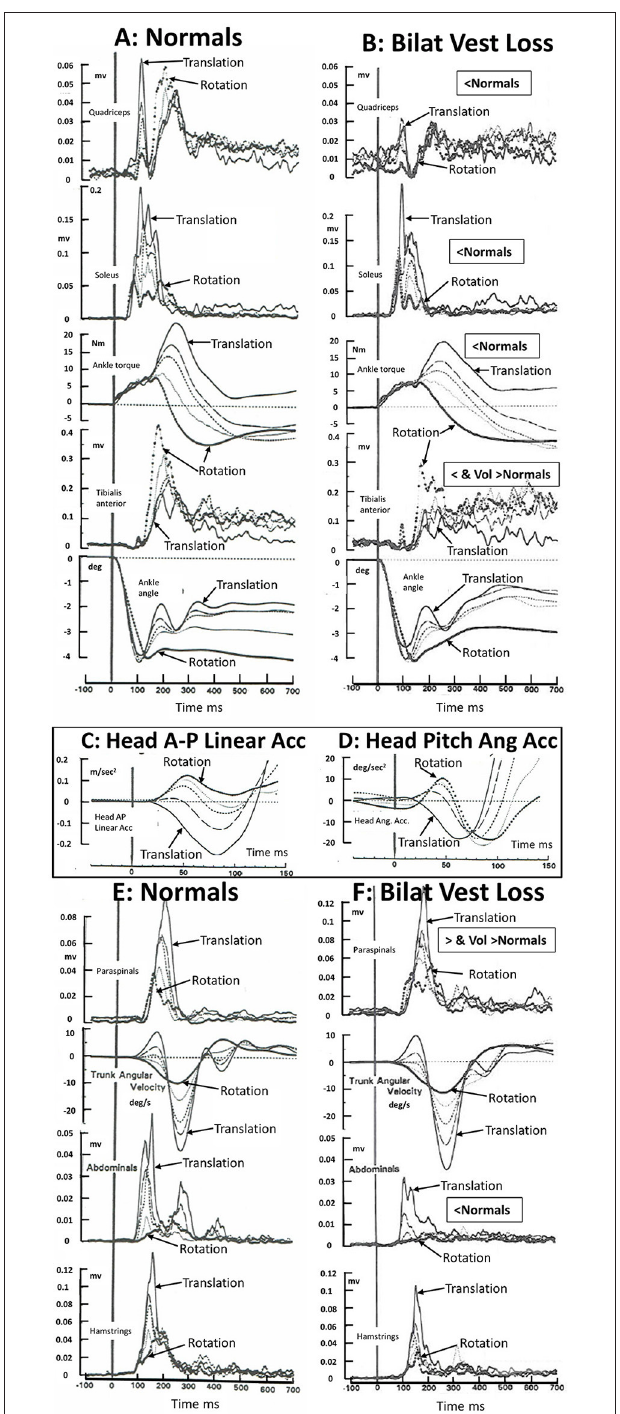
FIGURE 1 | Muscle activation patterns in 16 healthy normal subjects (A–E) and 5 bilateral peripheral vestibular loss (BVL) subjects) (B,F) to 36 ◦ /s toe up rotations of the support surface, 35 cm/s backwards translation of the support surface, and 3 combinations of rotation and translation. The support surface movements were designed to elicit 4 ◦ of ankle dorsiflexion at 100ms for all